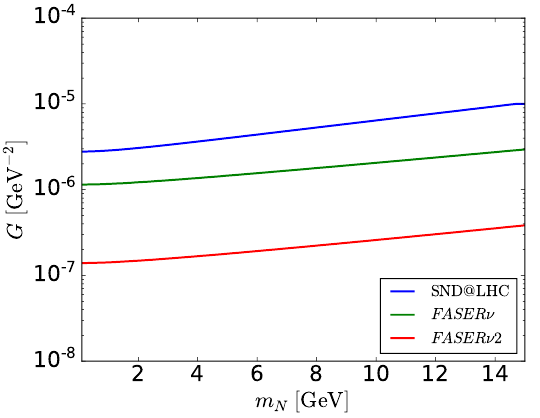
Figure 6 . Forecasted upper bound on G u = G d from SND@LHC, FASER ν and its upgrade FASER ν 2 in case of null signal. We have assumed integrated luminosity of 150 fb − 1 and 3000 fb − 1 , respectively, for run III of the LHC (SND@LHC and FASER ν ) and for HL-LHC (FASER ν